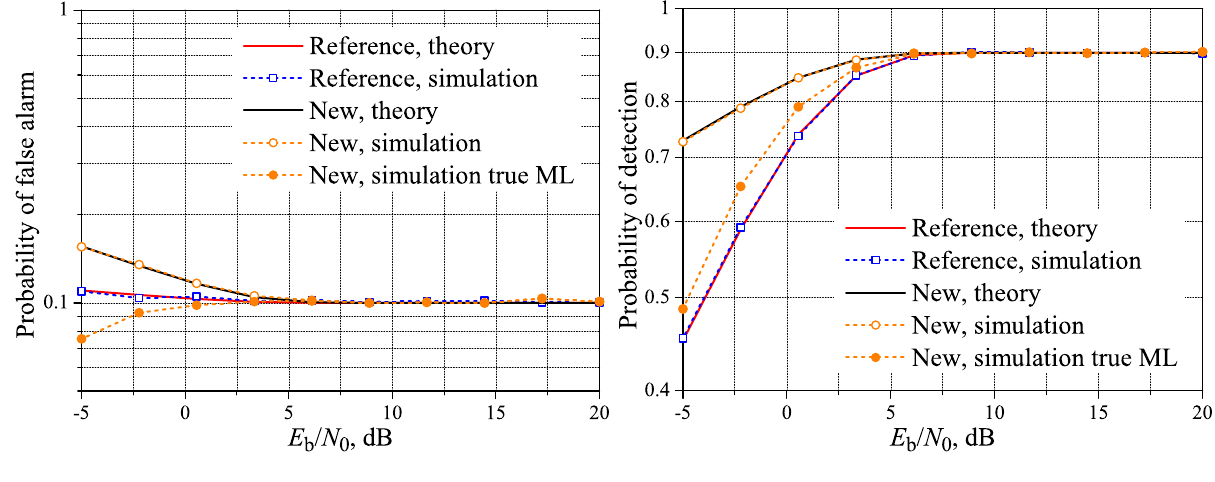
Figure 2. Spectrum sensing performance for the AWGN reporting channel. M = 3 and K = 1 ( top ), K = 2 ( middle ) and K = 3 ( bottom ).